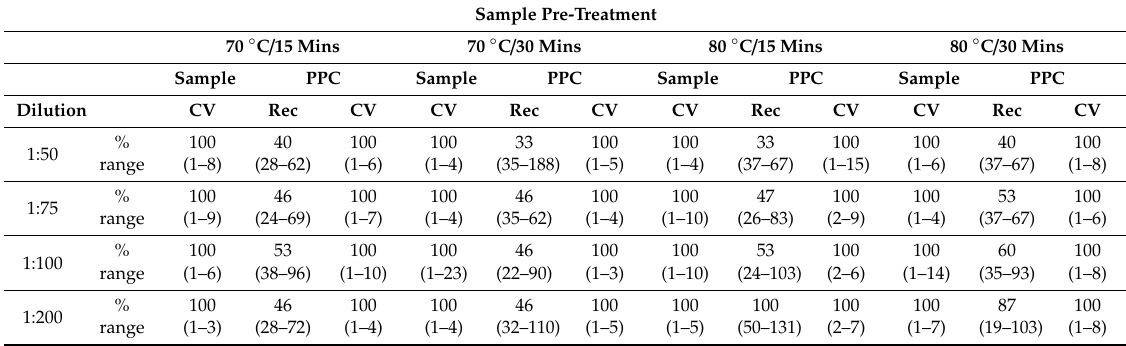
Table 1. Percentage of samples meeting inclusion criteria for analysis using the LAL assay.